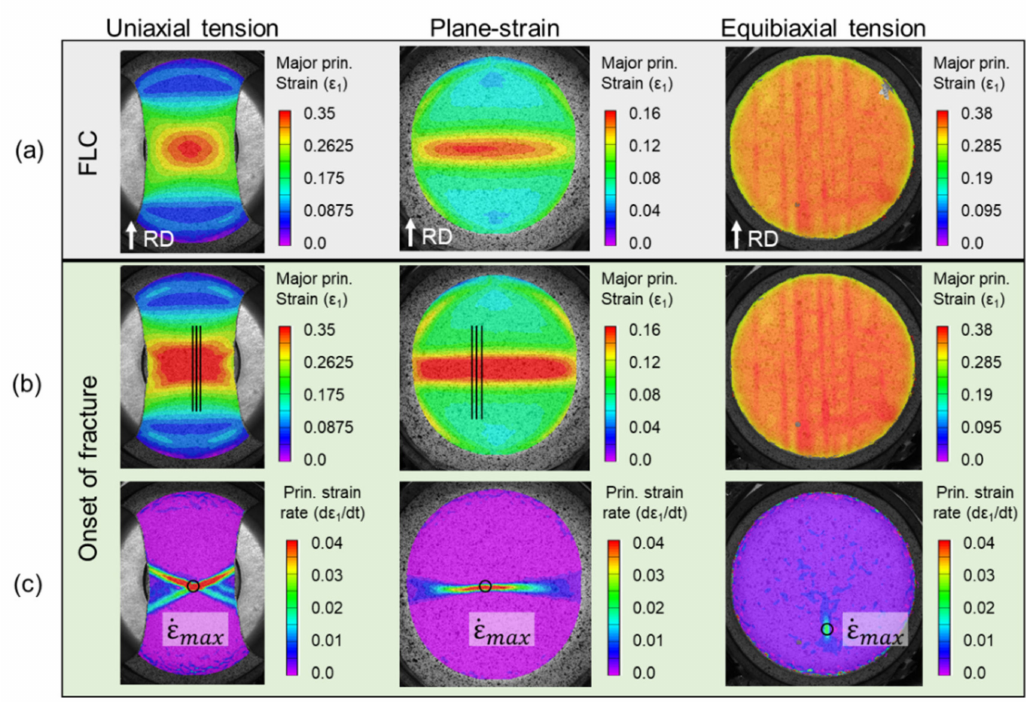
Figure 15. Contours of 1st principal strain during the FLC experiments ( a ) at FLC and ( b ) onset of fracture and ( c ) strain rate at onset of fracture. The lines and dots added to the images are explained in the text. Note that the scales are di ff erent, since each experiment deforms to di ff erent